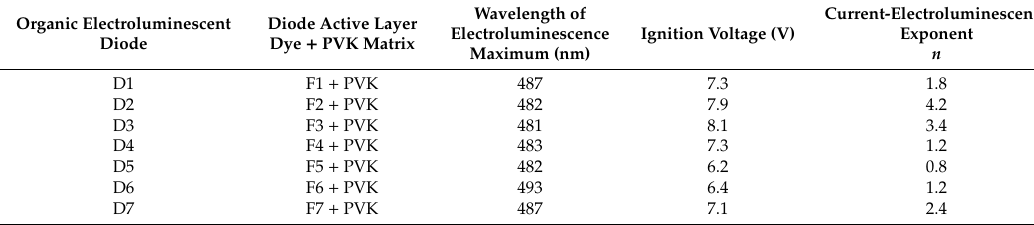
Table 6. Electroluminescent parameters of the organic diodes D1–D7.